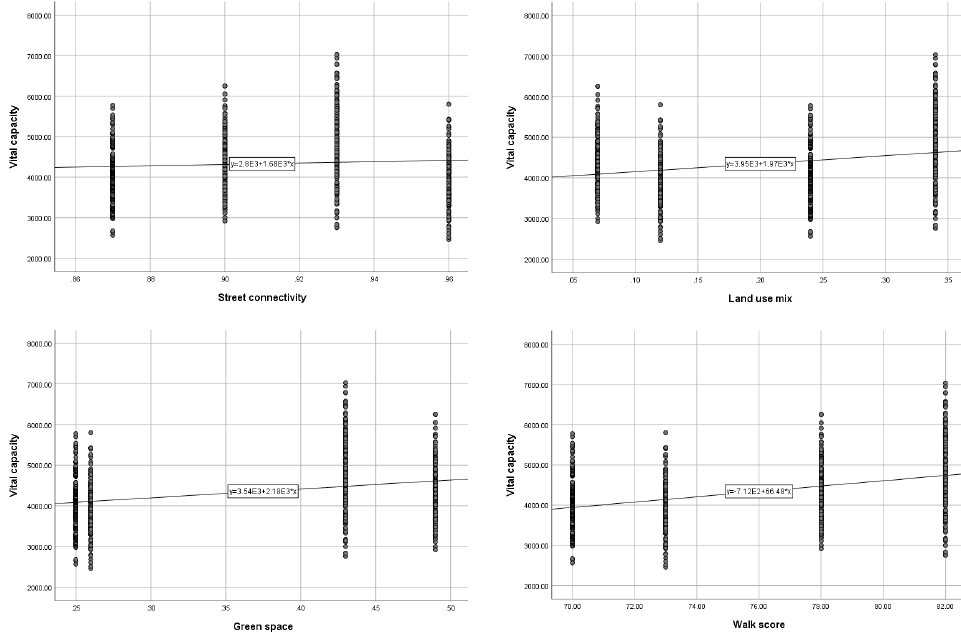
Figure A2. The specimen scatterplots for correlation between vital capacity and built environment in male students.